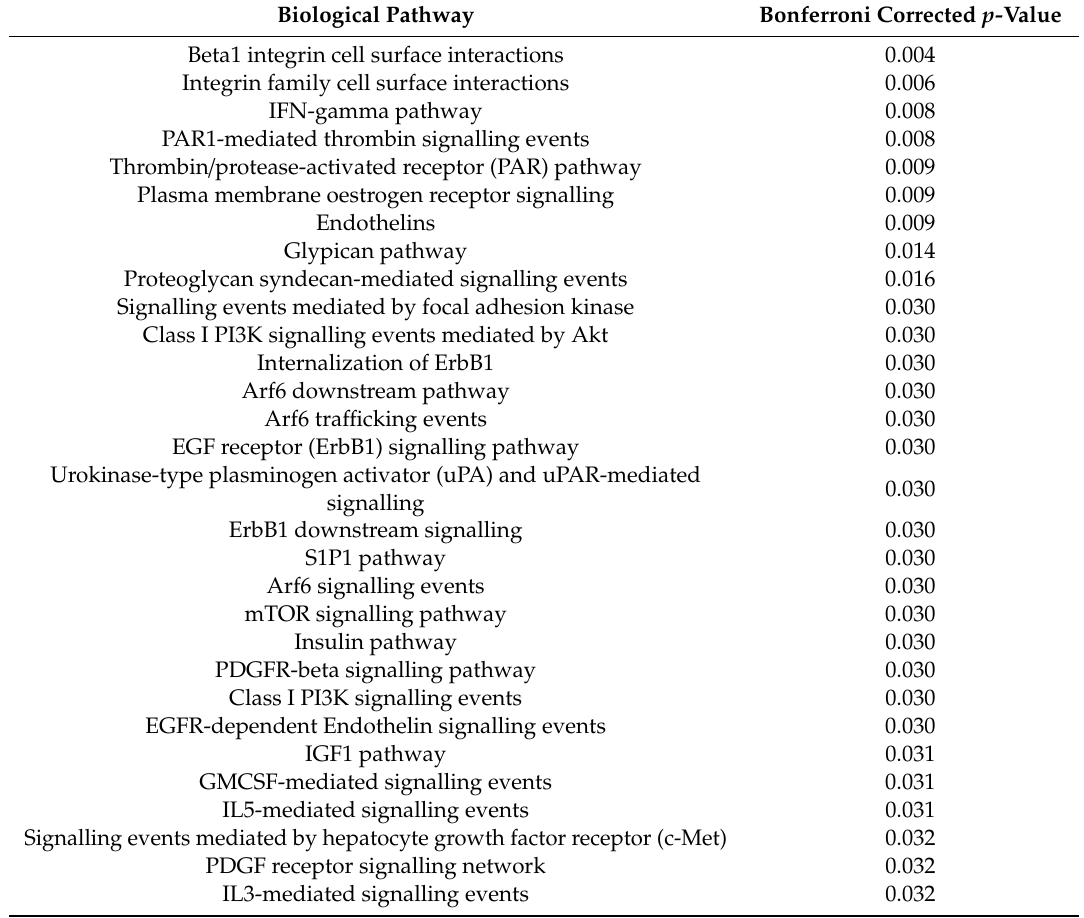
Table 5. Signalling pathways enriched in RA-DEGs that are targeted by